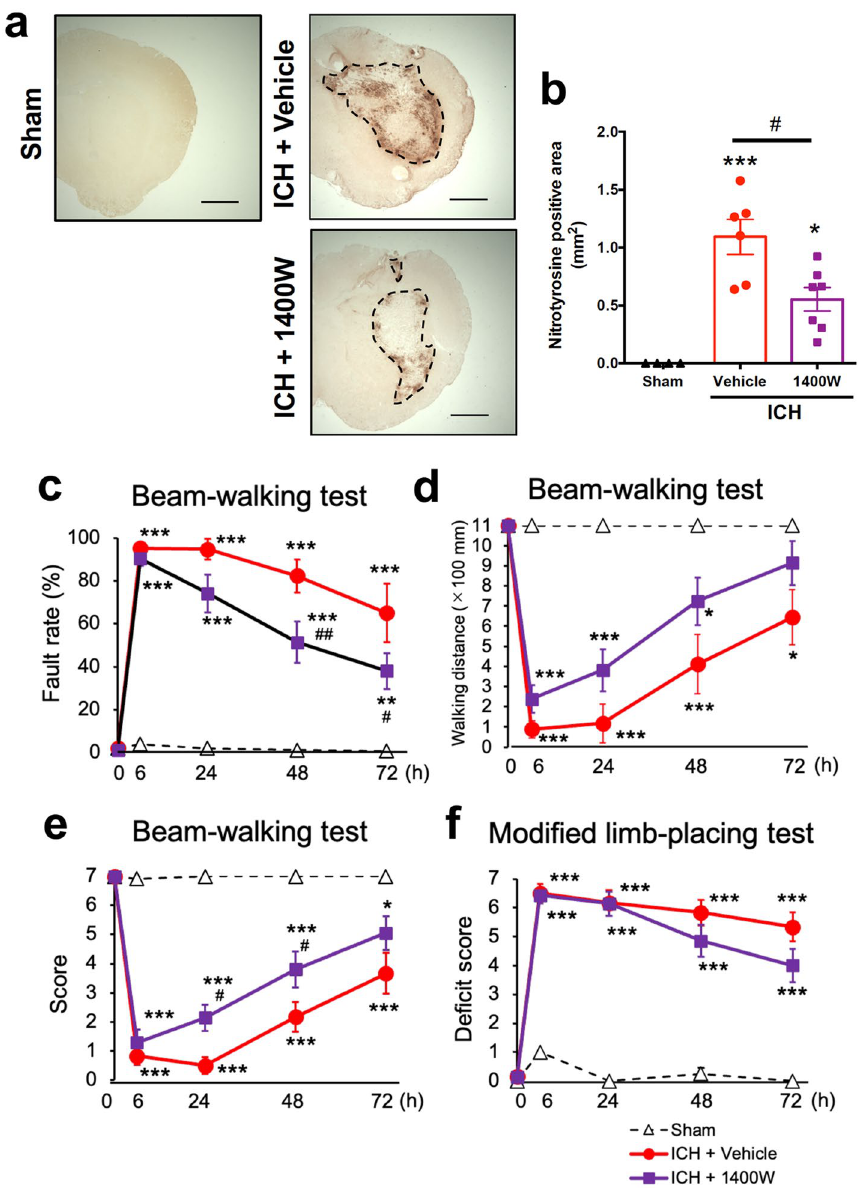
Figure 6. Effect of iNOS inhibitor on NO-related oxidative stress and motor performance after ICH. 1400 W (20 mg/kg) or vehicle was intraperitoneally administered twice daily for six times, from 3 h after ICH induction. ( a ) Representative images of nitrotyrosine immunohistochemistry. Scale bars = 1 mm. ( b ) Quantitative results of nitrotyrosine-positive area in the ipsilateral hemisphere. Number of mice examined was 4 in sham group, 6 in ICH + saline group and 7 in ICH + 1400 W group, respectively. *** P < 0.001 versus sham group, # P < 0.05. (ANOVA results: F 2,14 = 15.99, P < 0.001) ( c-e ) Results of performance in the beam-walking test evaluated by foot fault rate ( c ), walking distance ( d ) and performance score ( e ). Results of two-way repeated measure ANOVA were as follows. Concerning the fault rate: interactions, F 8,56 = 11.00, P < 0.001; time, F 4,56 = 46,80, P < 0.001; treatment, F 2,14 = 34.47, P < 0.001. Concerning the walking distance: interactions, F 8,56 = 6.830, P < 0.001; time, F 4,56 = 28.95, P < 0.001; treatment, F 2,14 = 18.18, P < 0.001.. Concerning the performance score: interactions, F 8,56 = 11.73, P < 0.001; time, F 4,56 = 51.50, P < 0.001; treatment, F 2,14 = 35.62, P < 0.001. ( f ) Results of performance in the modified limb-placing test. Two-way repeated measure ANOVA: interactions, F 8,56 = 12.66, P < 0.001; time, F 4,56 = 69.43, P < 0.001; treatment, F 2,14 = 63.77, P < 0.001. Number of mice examined in ( c - f ) was 4 in sham group, 6 in ICH + vehicle group and 7 in ICH + 1400 W group, respectively. * P < 0.05, ** P < 0.01, *** P < 0.001 versus sham group, # P < 0.05, ## P < 0.01 versus ICH + vehicle